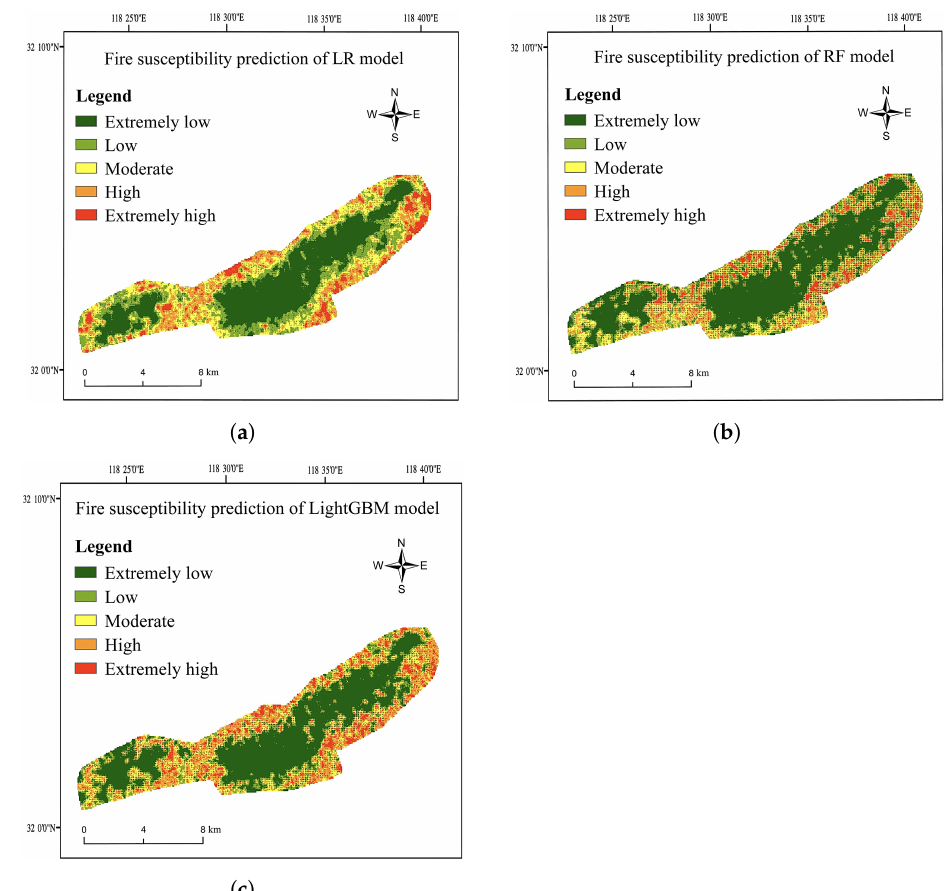
Figure 8. Forest fire susceptibility maps. ( a ) LR; ( b ) RF; and ( c )